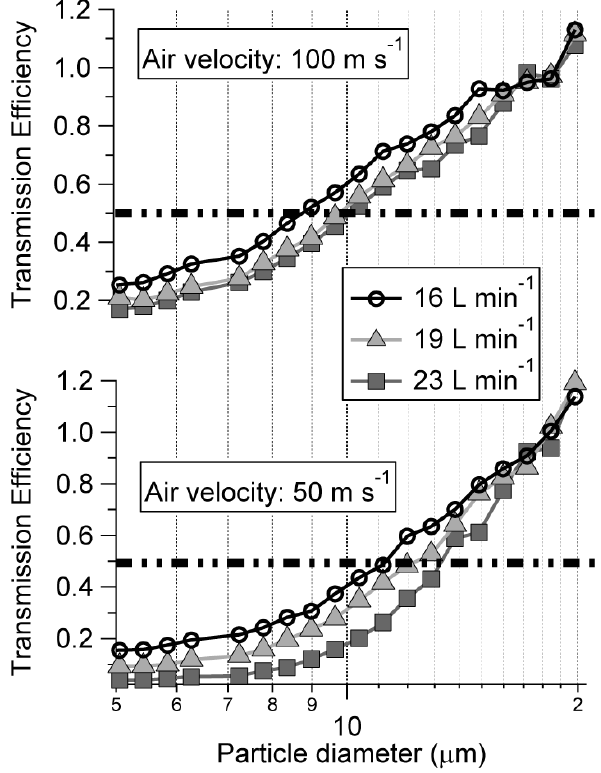
Fig. 3. Transmission efficiency of hollow glass beads at different add-flow rates based on counter-flow mode experiments conducted with the BMI wind tunnel at different air velocity conditions (50 and 100ms − 1 ) . The dashed horizontal lines correspond to 50% transmission efficiency, which defines the inlet cut size ( D p , 50 ) .